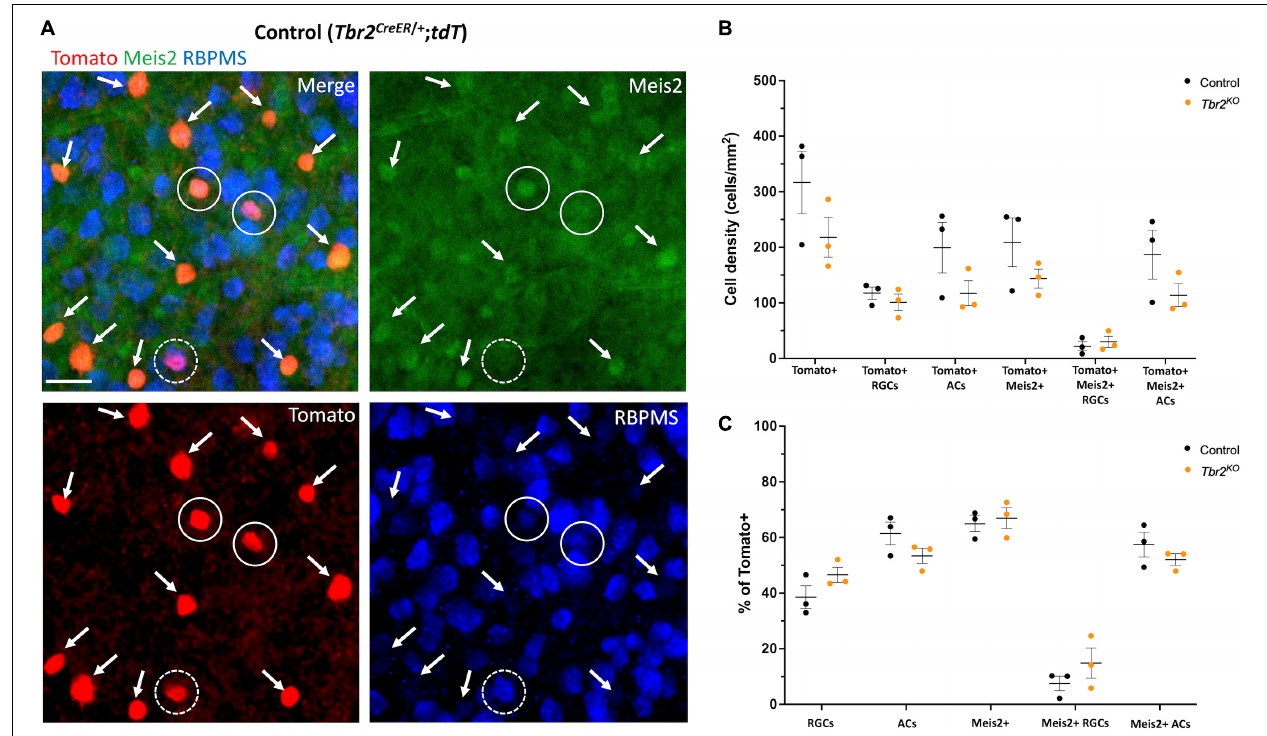
FIGURE 5 | Meis2 is expressed in the majority of Tbr2-expressing displaced amacrine cells and in a subset of Tbr2-expressing RGCs. (A) Flatmounted retina of a control ( Tbr2 CreER / + ;tdT) mouse immunostained to reveal expression of tomato (red), Meis2 (green), and RBPMS (blue). First image is a merge of all color channels, others are showing each channel independently; arrows point to Tomato + ACs expressing Meis2; closed white circles represent Tomato + RGCs expressing Meis2; dashed white circles indicate Tomato + RGCs that do not express Meis2. All Tomato + ACs in this image express Meis2. (B) Quantification of the density (cells/mm 2 ) of cell populations of interest in control and Tbr2 KO mice ( n = 3 mice in each group, each dot represents the sum of 4 FOVs per retina, mean ± SEM displayed; two-way ANOVA with Sidak’s multiple comparisons test; no significant differences). There is a trend toward a decrease in the density of labeled amacrine cells in Tbr2 KO mice. (C) Quantification of the percentage of Tomato + cells that belong to cell populations of interest in control and Tbr2 KO mice ( n = 3 mice in each group; each dot represents the percentage for 4 summed FOVs of 1 retina; mean ± SEM displayed; two-way ANOVA with Sidak’s multiple comparisons test; no significant